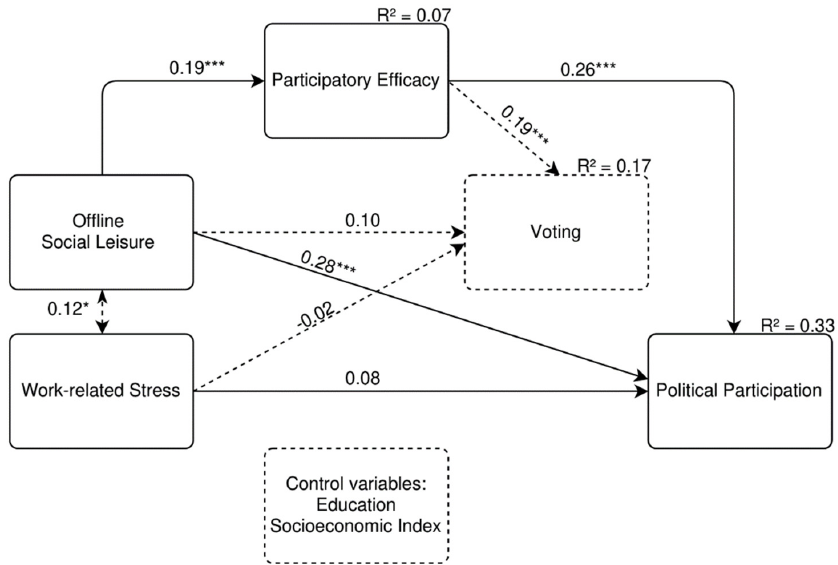
Figure 2. Pathways’ effect sizes for the conceptual model of the relationship between work-related stress/offline social leisure and political participation. The political participation variable does not contain voting. The full lines denote the main analysis pathways, whereas dotted lines represent exploratory analysis pathways. * p < 0.05 *** p < 0.001.